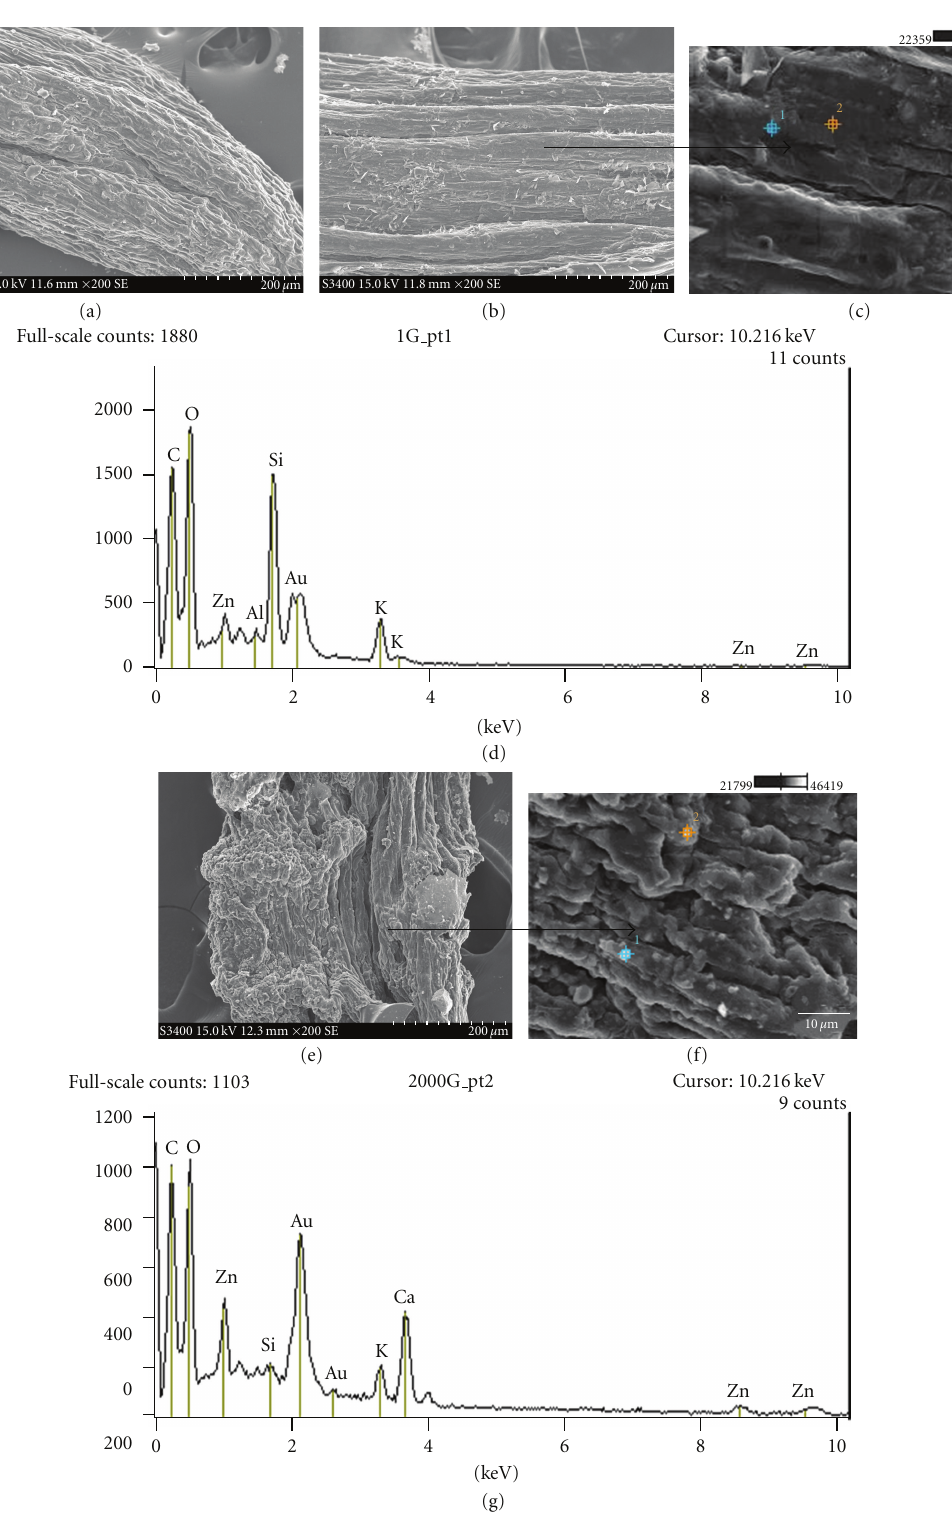
Figure 7: Scanning electron micrographs of roots of gram (Cicer arietinum) (a) control, (b) at 1ppm with EDAX (c) and (d) and (e) at 2000 ppm with EDAX (f) and (g) of nano-ZnO treatment. The energy dispersive spectroscopy shows the Zn peaks obtained from points indicated by the